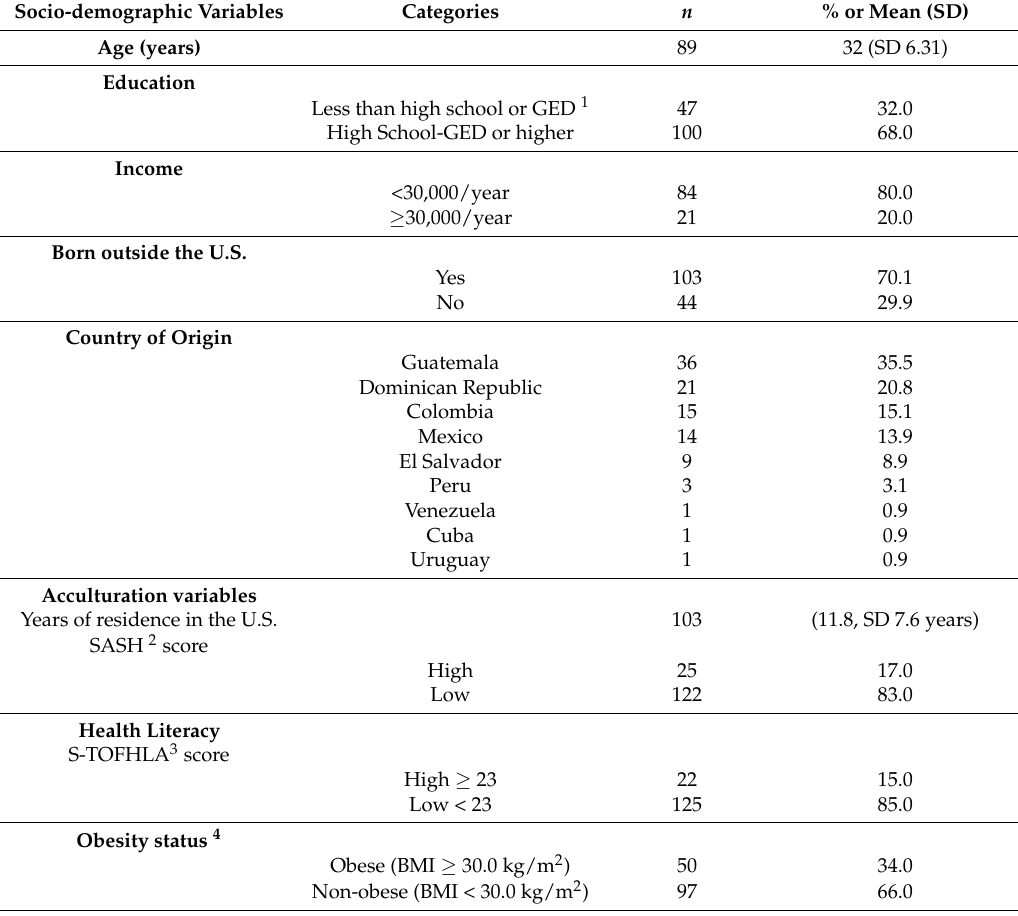
Table 1. Characteristics of study the sample ( n =